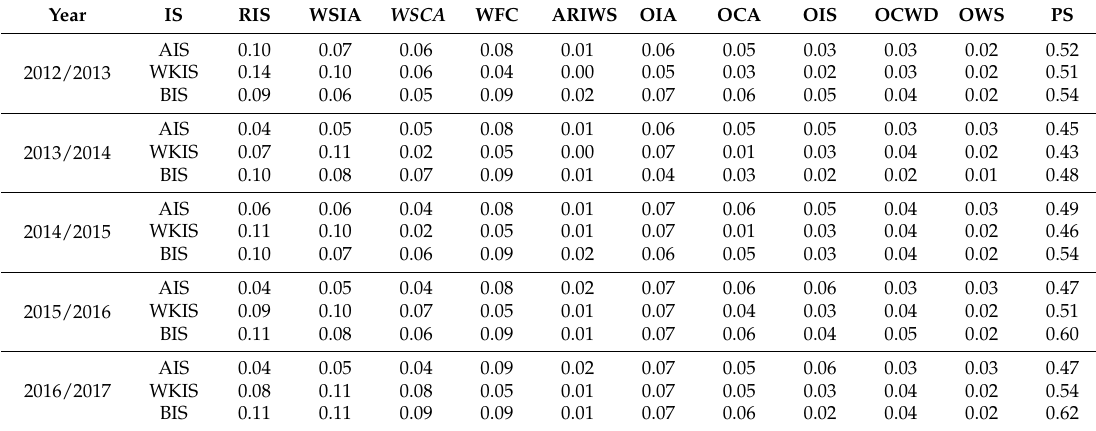
Table 12. Weighted performance score for each